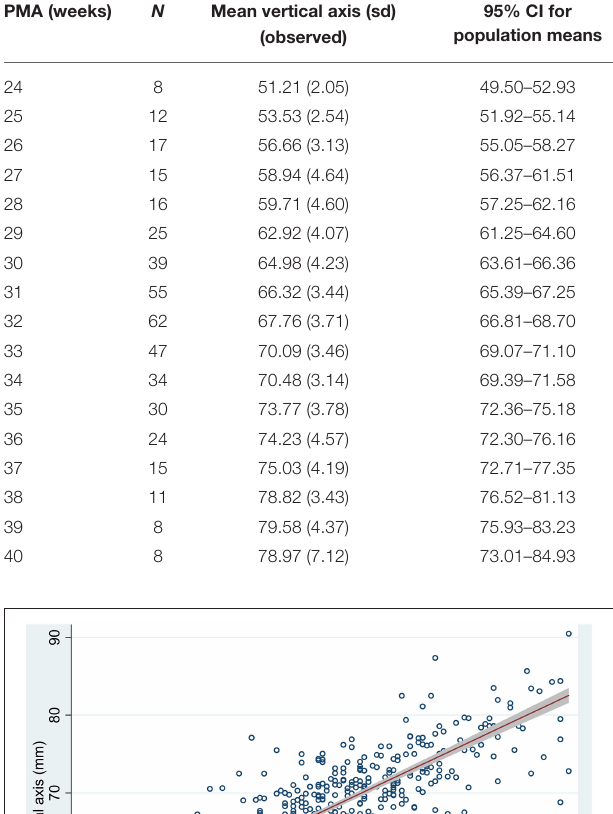
TABLE 4 | Mean US anteroposterior axis (sd) in millimeters per week of post-menstrual age and 95% CI for population means. PMA (weeks)